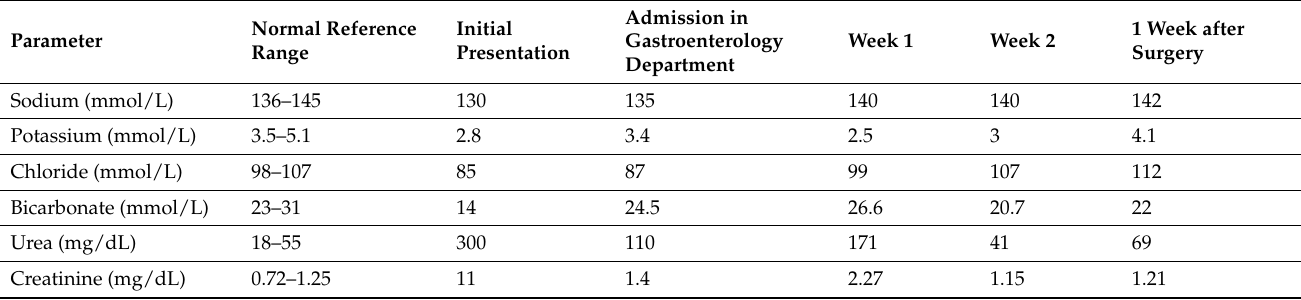
Table 1. Blood tests results.